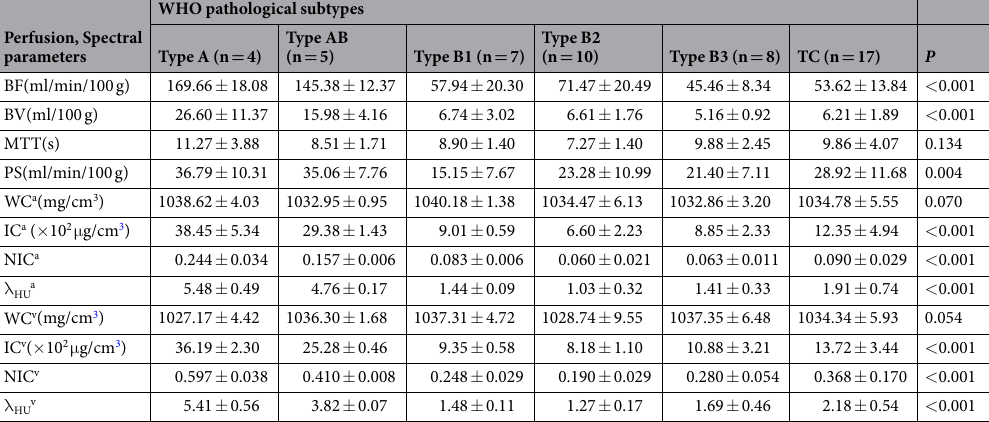
Table 4. Perfusion and spectral parameters in the different WHO pathological subtypes of 51 TETs. BF, blood flow; BV, blood volume; MTT, mean transit time; PS, permeability surface. WC, water concentration; IC iodine concentration; NIC, normalized iodine concentration; λ HU , slope of spectral HU curve. a, the optimal arterial phase; v, the optimal venous phase. TC, thymic